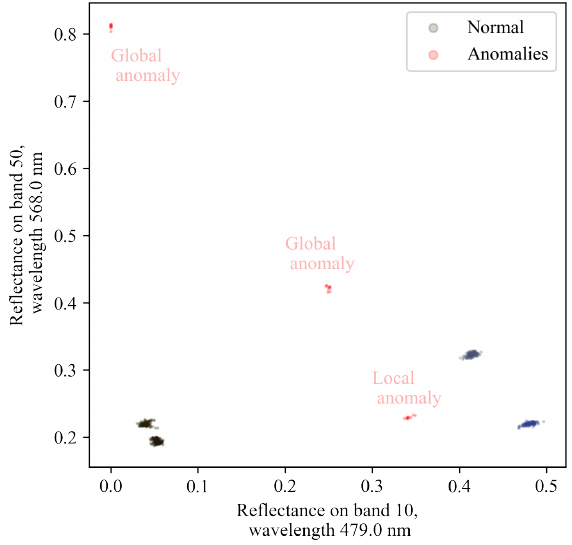
Figure 1. Example of two bands from hyperspectral test